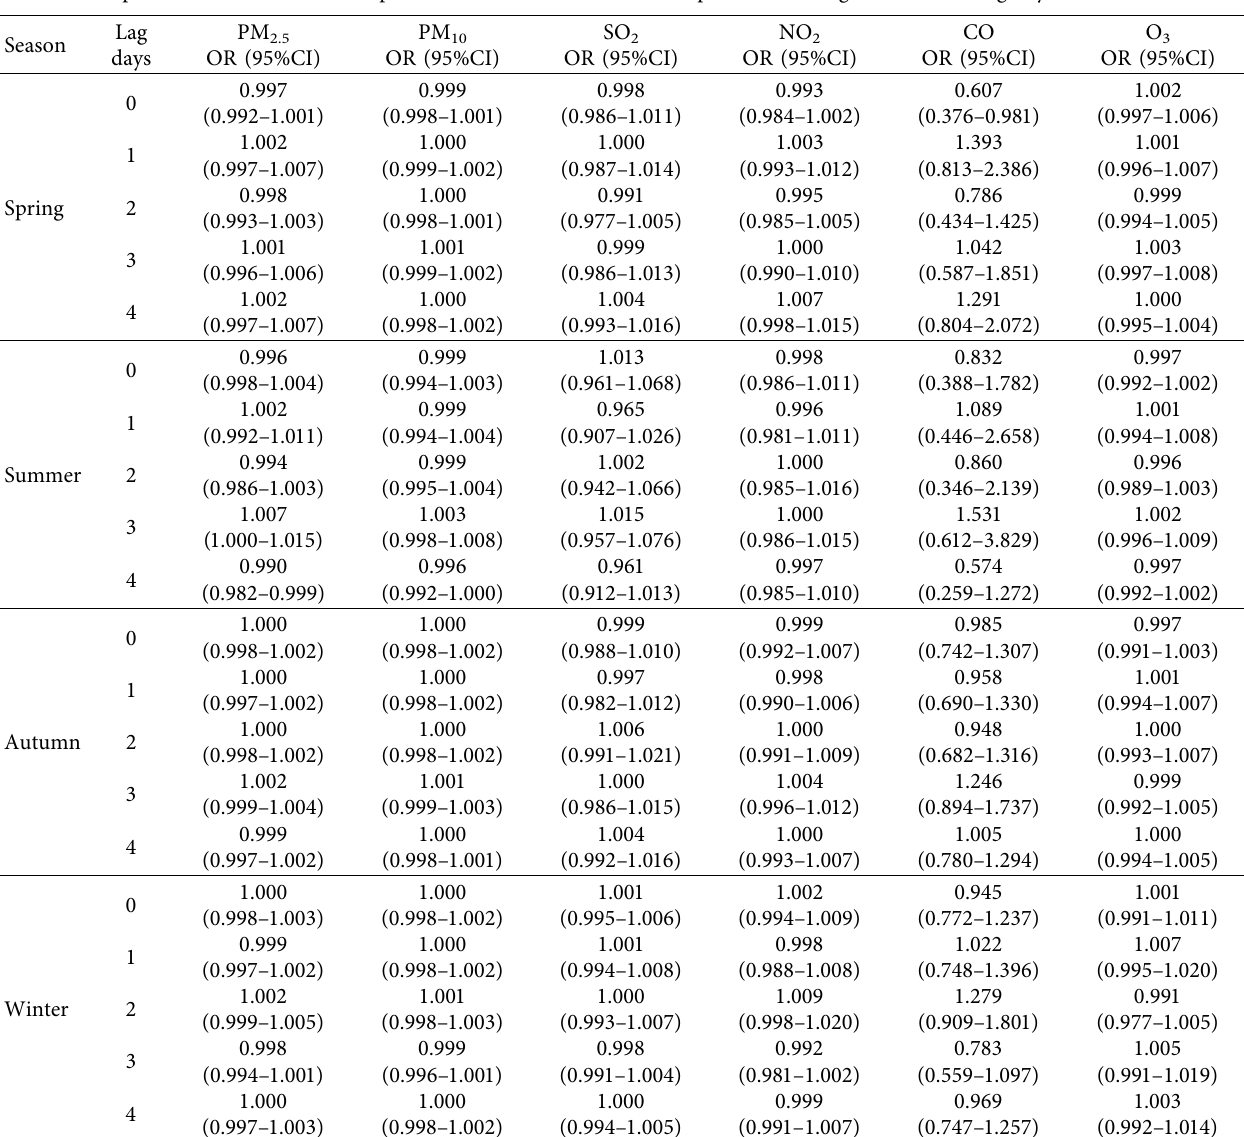
Table 2: Hospital admissions for COPD patients and concentrations of air pollutants change on different lag days in different seasons. Season